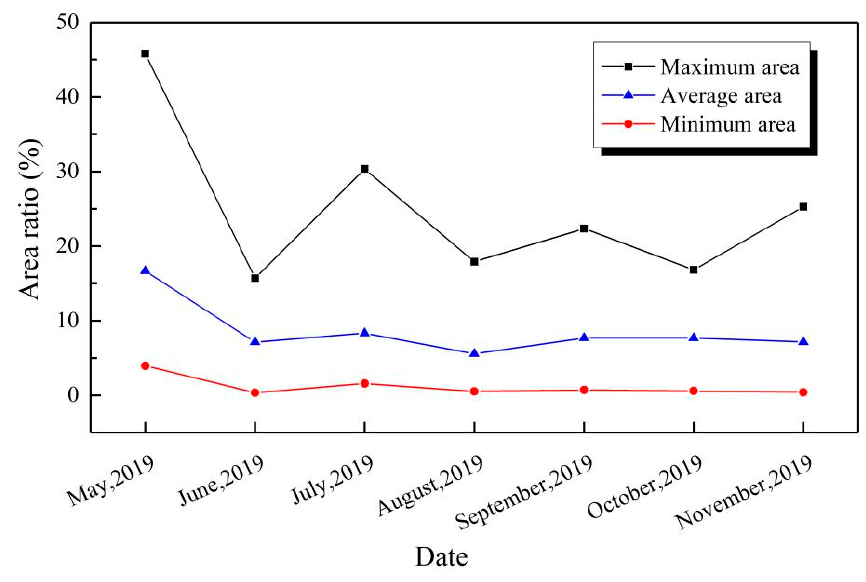
Figure 10. The ratios of the monthly maximum, minimum, and average HAB area to the total HAB area per month (total HAB area: monthly statistics of the area where HAB occurs each time).